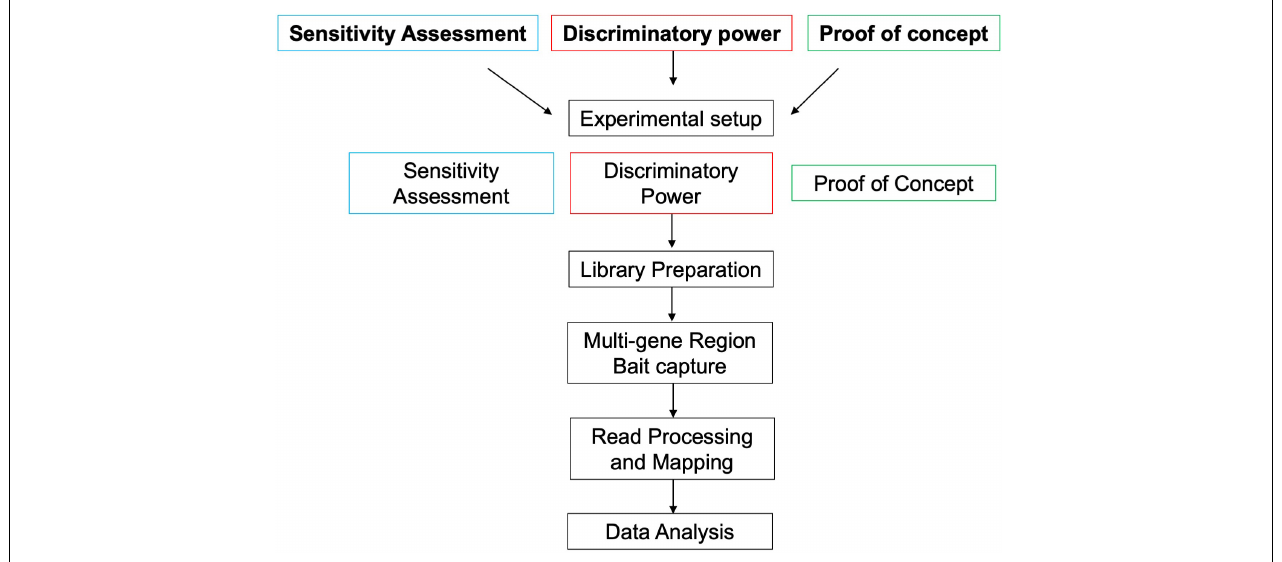
FIGURE 1 | Flow diagram outlining the different tests for this study.